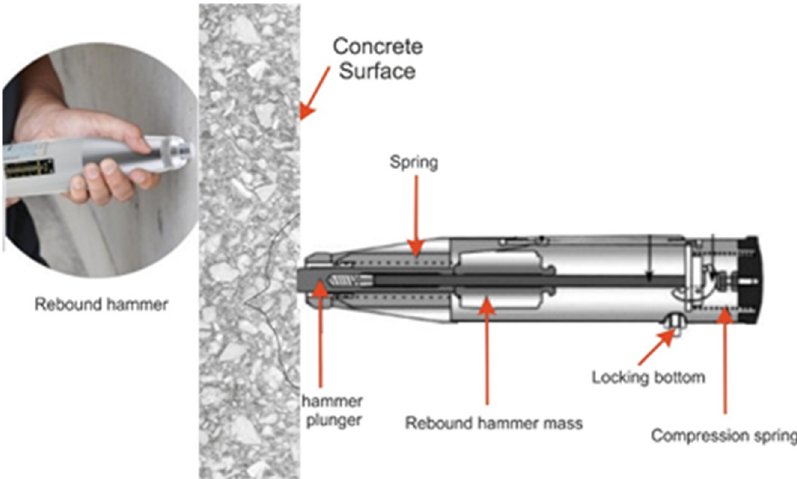
Figure 12. Rebound hammer typical scheme